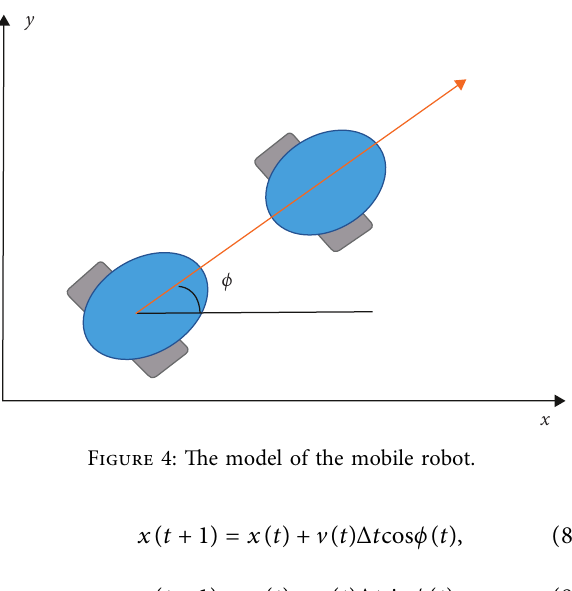
Figure 4: The model of the mobile robot.